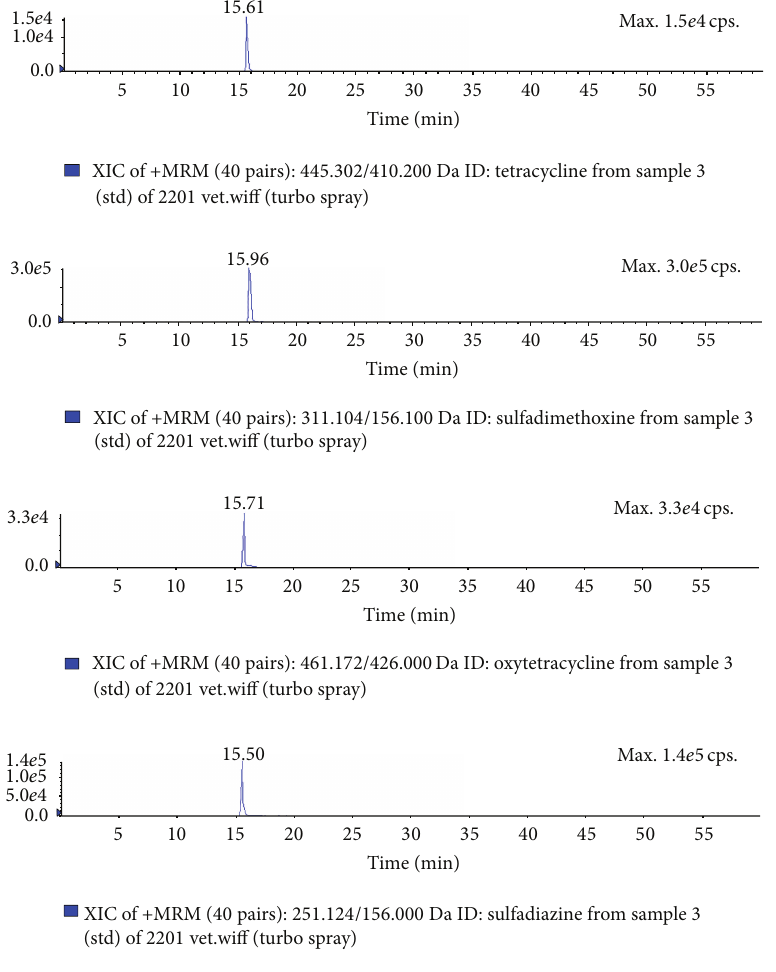
Figure 3: MRM chromatograms of milk samples at the LOQ level of tetracyclines, sulfadimethoxine, oxytetracycline, and sulfadiazine (10 𝜇